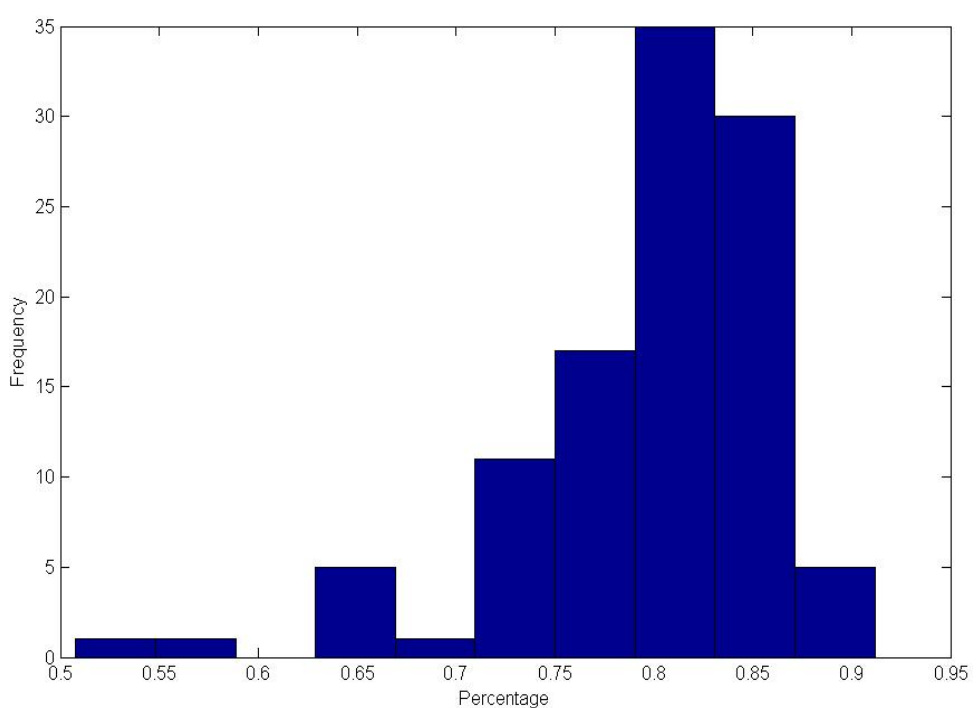
Figure 13. Histograms of the percentage by four training